Question: What kind of plot is shown here?
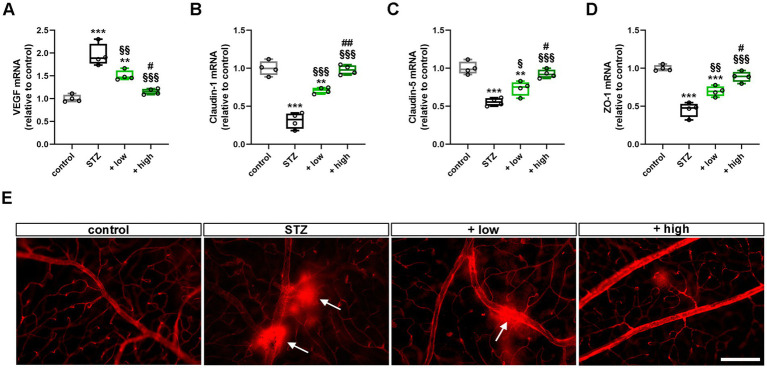
Answer: box